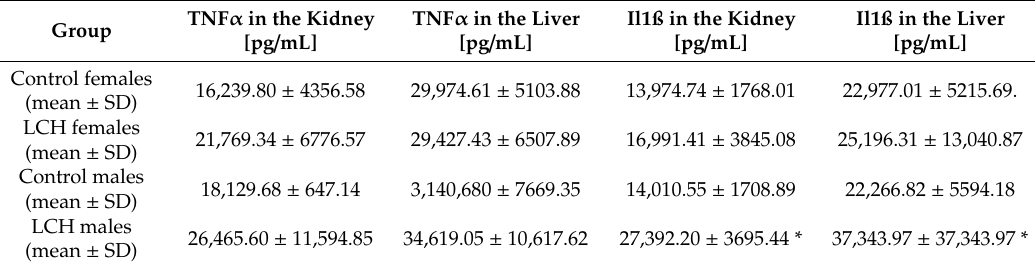
Table 4. TNF α and IL1ß in the livers and